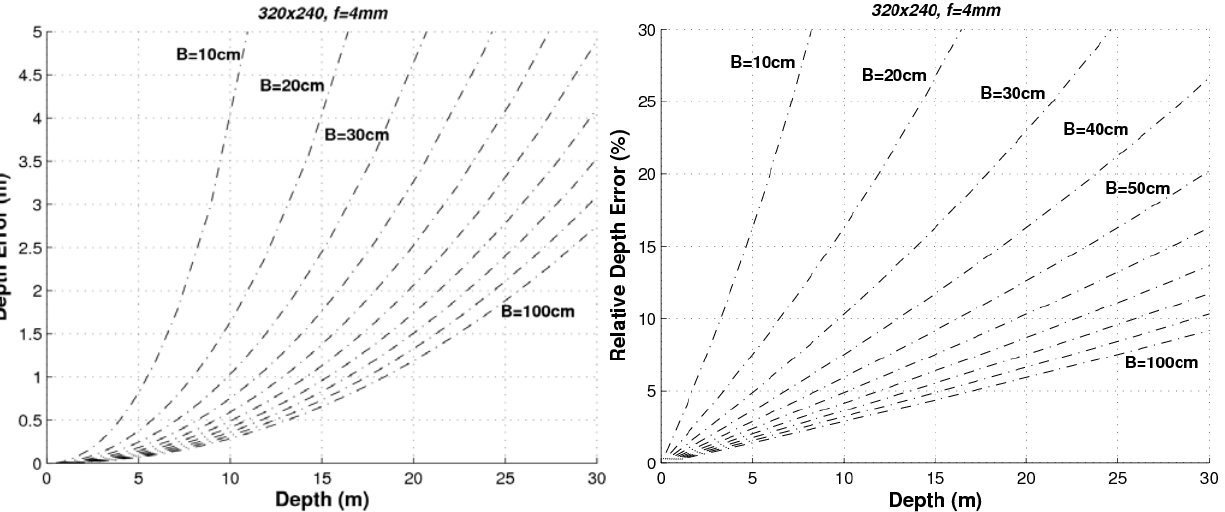
Figure 4. Absolute and relative depth estimation errors for a stereo sensor with f = 4 mm and image size of 320 × 240 px, for different